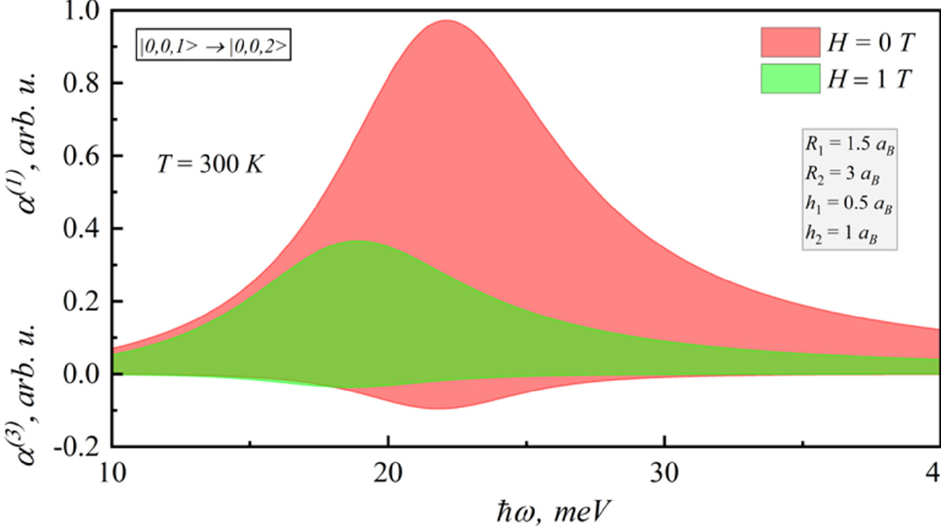
Figure 7. Spectral dependences of the linear and nonlinear intraband absorption coefficients on photon energy for different magnetic fields.